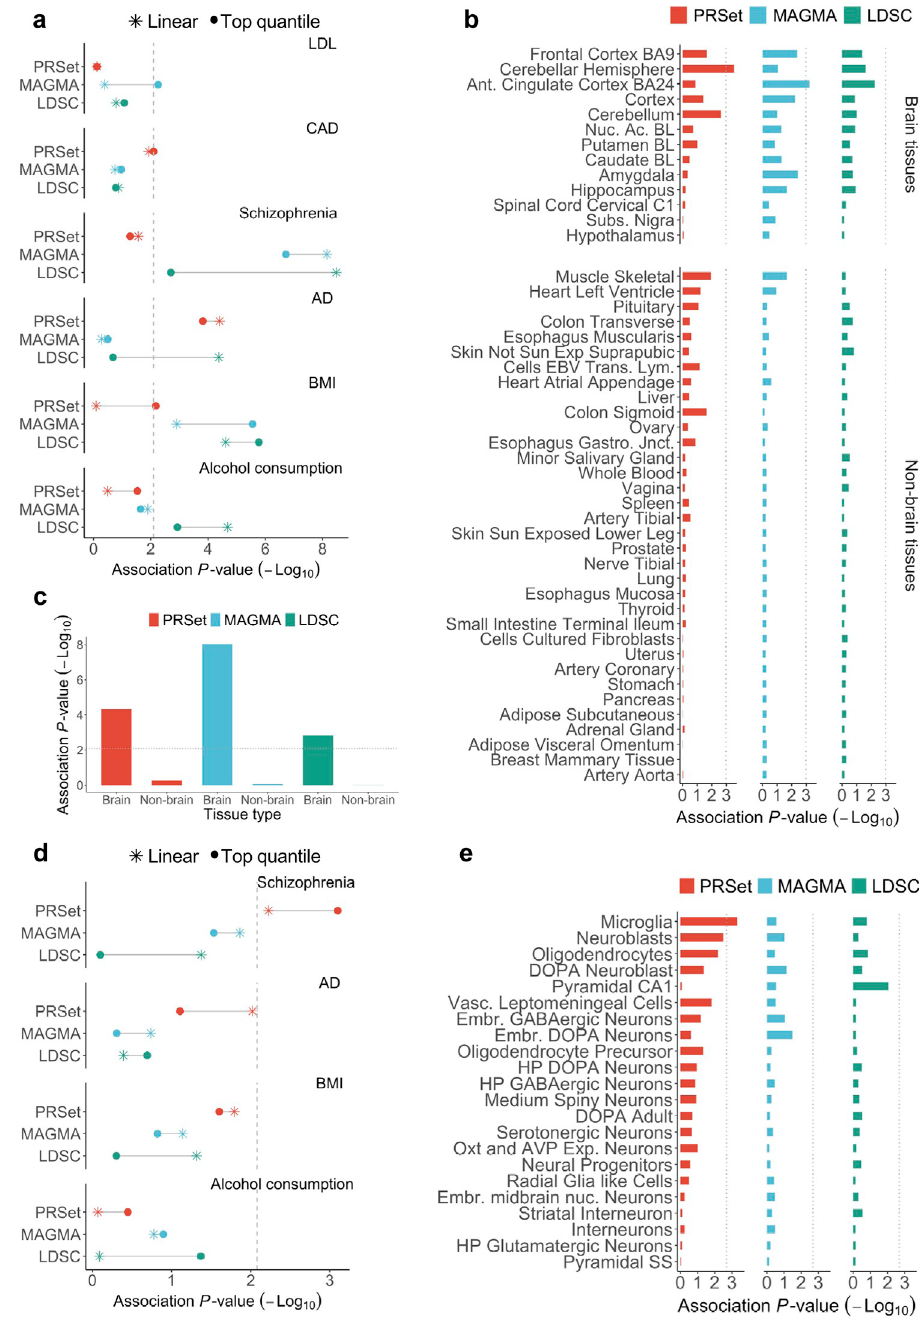
Fig 3. Performance of PRSet, MAGMA and LDSC for ranking of pathways defined by tissue-type and cell-type expression specificity. A, Association between pathway enrichment P -value and expert opinion of tissue relevance for each software and six diseases. Colours indicate the software used to calculate enrichment: Red, PRSet; Blue, MAGMA; Green, LDSC. Results are shown for both the top quantile and linear specificity test methods ( Methods ). Dashed line corresponds to Bonferroni significance threshold of 0.05 for 6 tests (3 methods x 2 test models). B, Pathway enrichment results for schizophrenia under the top quantile test model. Bar plots show enrichment P-value for each tissue and pathway method. Dashed line corresponds to Bonferroni significance threshold for 47 tissues (-log10(0.05/ 47) = 2.97). Ant, Anterior; Nuc. Ac., Nucleus Accumbens; BL, Basal Ganglia; Subs, Substantia; Exp, Exposed; EBV Trans. Lym., Epstein-Barr virus transformed lymphocytes; Gastro. Jnct, Gastroesophageal Junction. C, Enrichment of schizophrenia signal is higher in brain tissues vs non-brain tissues under the top quantile test model. Bar plots show the meta-analysis enrichment P- value using the Fisher’s method for brain vs non-brain tissue and method. Dashed line